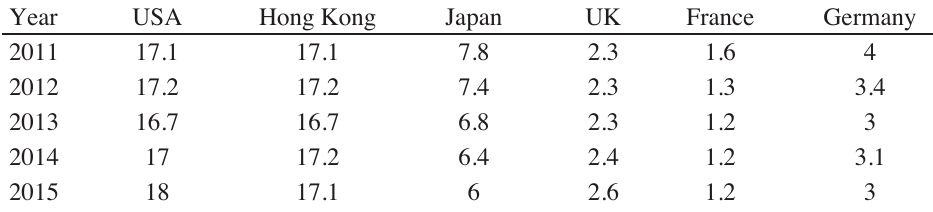
China Export %, to Major Trading Partners